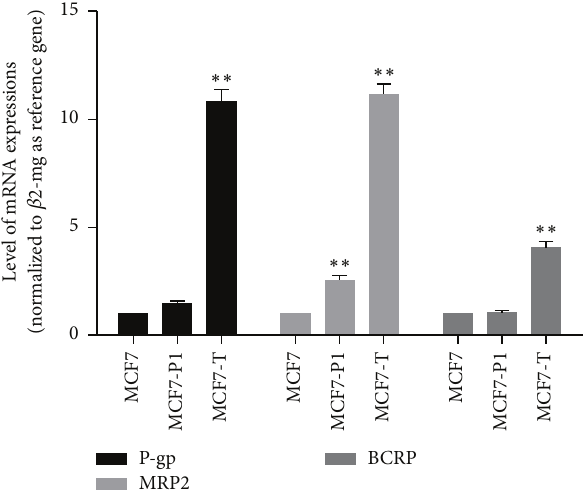
Figure 6: Level of mRNA expressions of P-glycoprotein, MRP2, and BCRP after 5 days of treatment (MCF7-P1) or 44 days of treatment (MCF7-T) with tamoxifen 1 𝜇 M. Results were shown as mean ± SD ( 𝑁 = 4 ); ( ∗∗ ) Significant difference versus MCF7 parent cells at 𝑝 < 0.001 .